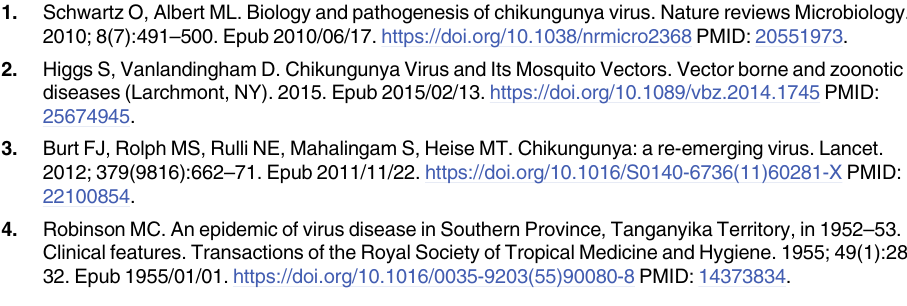
S2 Table. Lists with phosphorylation sites that were significantly modulated during CHIKV infection. Each time point is placed in a separate sheet. S3 Table. List of oligonucleotide